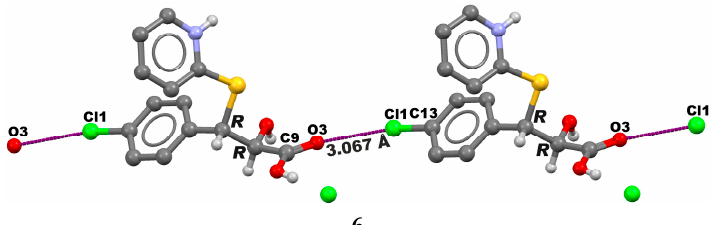
Figure 5. Halogen bonds in 6 (shown as dashed purpura lines).